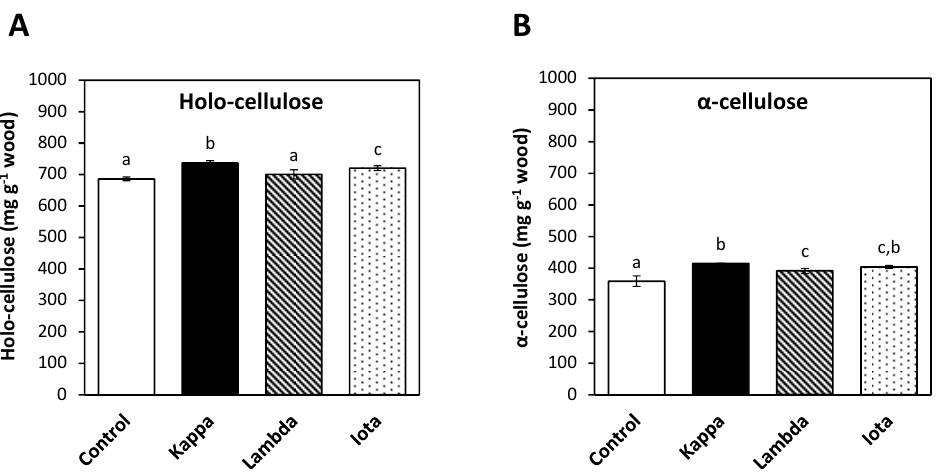
Figure 2. Contents of holo-cellulose ( A ) and α -cellulose ( B ) in branches of control Eucalyptus (control) and in trees treated with oligo-carrageenans (OCs) kappa, lambda and